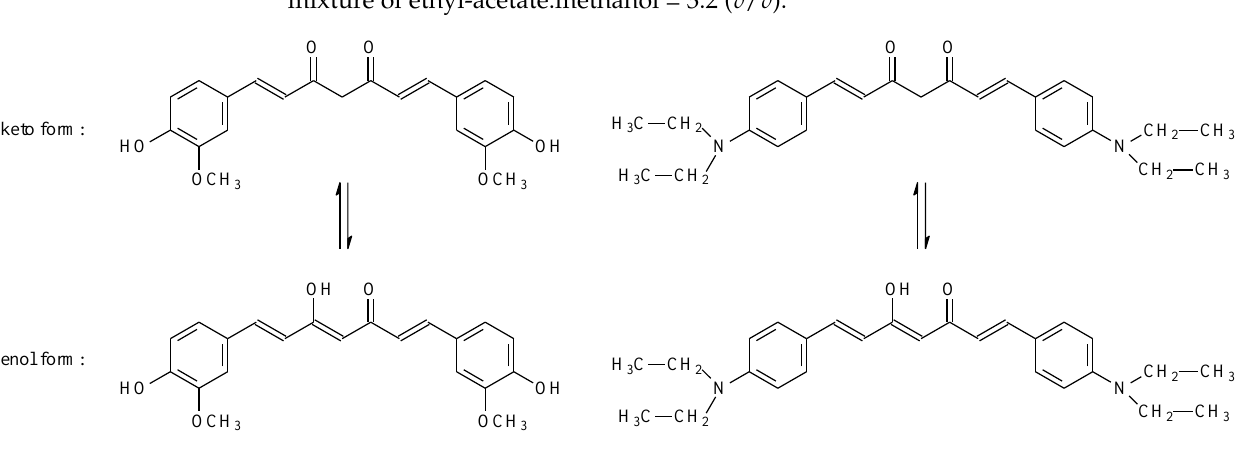
Figure 1. Keto-enol tautomeric forms of curcumin derivatives.